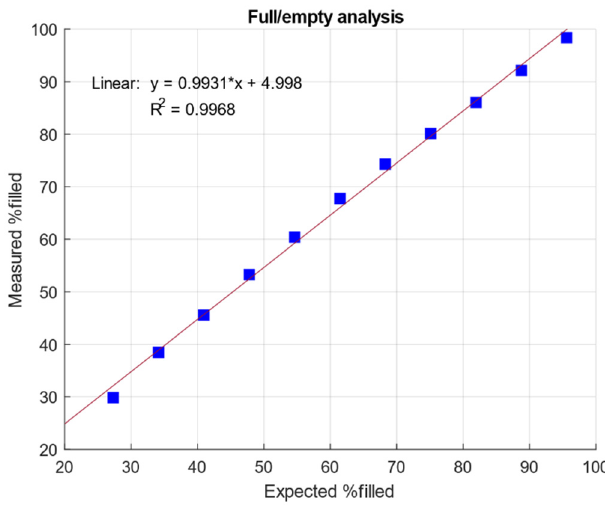
Figure 2. Linear correlation of measured % filled AAV capsids using IEC-MALS and expected % filled AAV capsids by AUC.